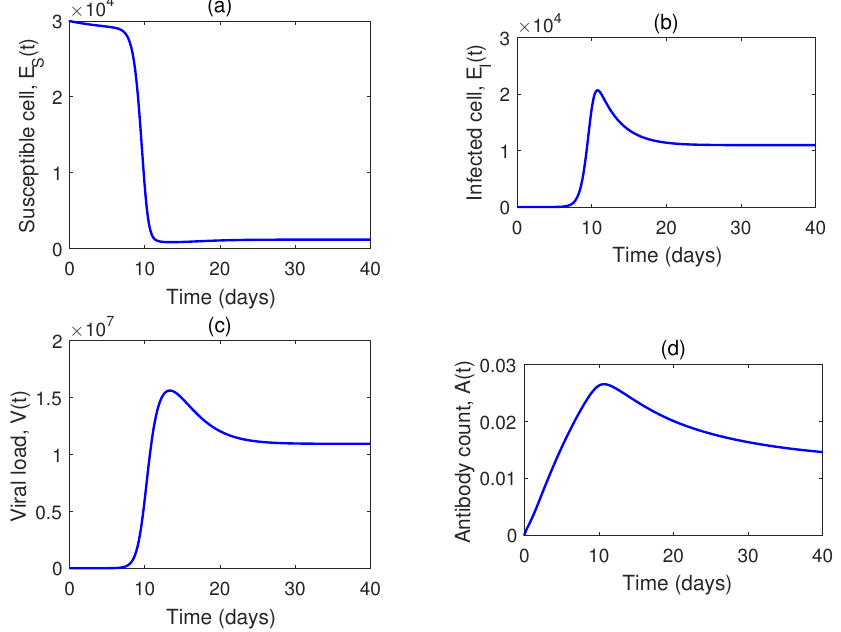
Figure 4. ( a – d ) Numerical solution of Model (2) for the set of parameters in Table